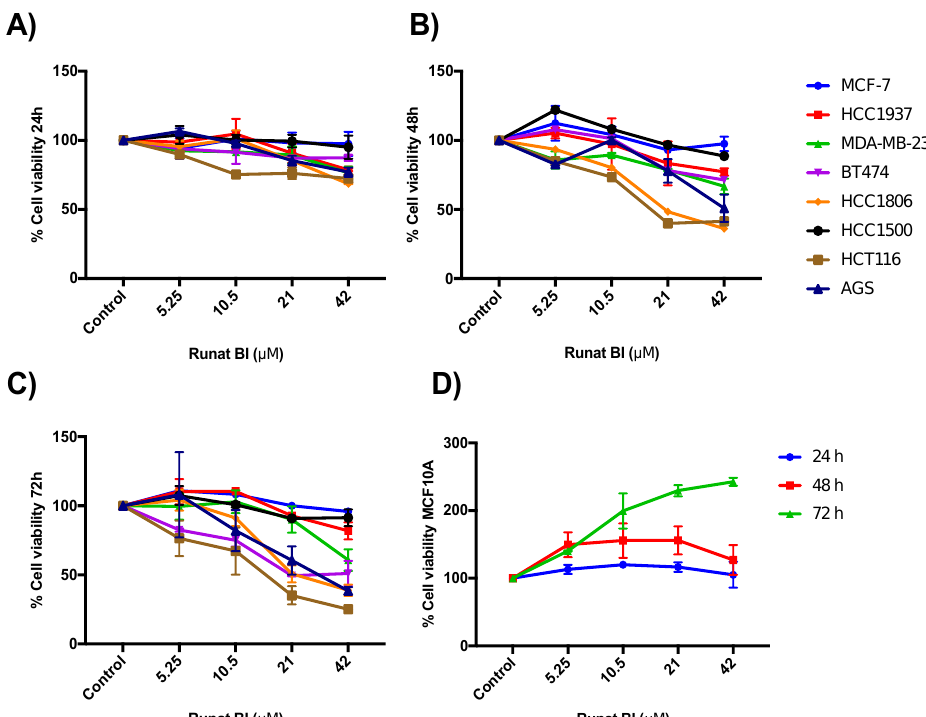
Figure 2. Viability percentages of the nine cell lines treated with Runat-BI at 24, 48 and 72 h. The breast cancer cell lines (MCF-7, HCC1937, MDA-MB-231, BT474, HCC1806, HCC1500), gastric cancer cell line (AGS) and colon cancer cell line (HCT116) were treated with Runat-BI at different concentrations (0 to 42 µM) for 24 h ( A ), 48 h ( B ), and 72 h ( C ). The mammary gland cell line MCF10A was used as a non-tumor cell line and was treated with Runat-BI at the same concentrations and time: 24 h (blue), 48 h (red) and 72 h (green) ( D ). Cell proliferation was determined with the MTT assay. Dots indicate the mean of three independent experiments.